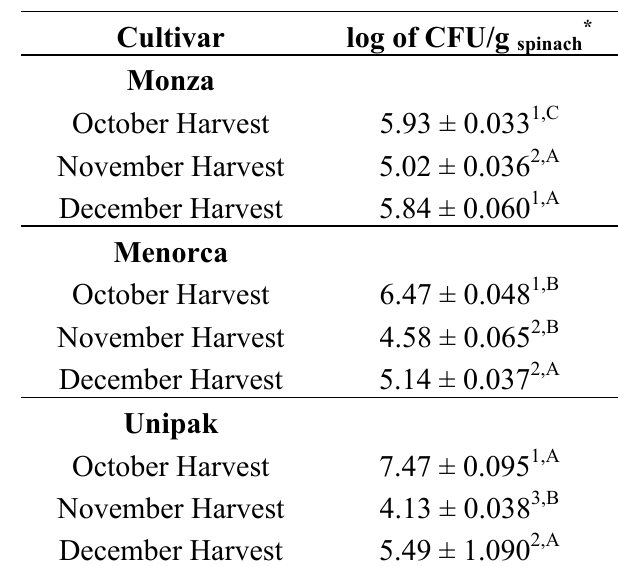
Table 3. Number of culturable epiphytic bacteria on baby spinach leaves for the three spinach cultivars harvested at three different time points as determined by plating on R2A